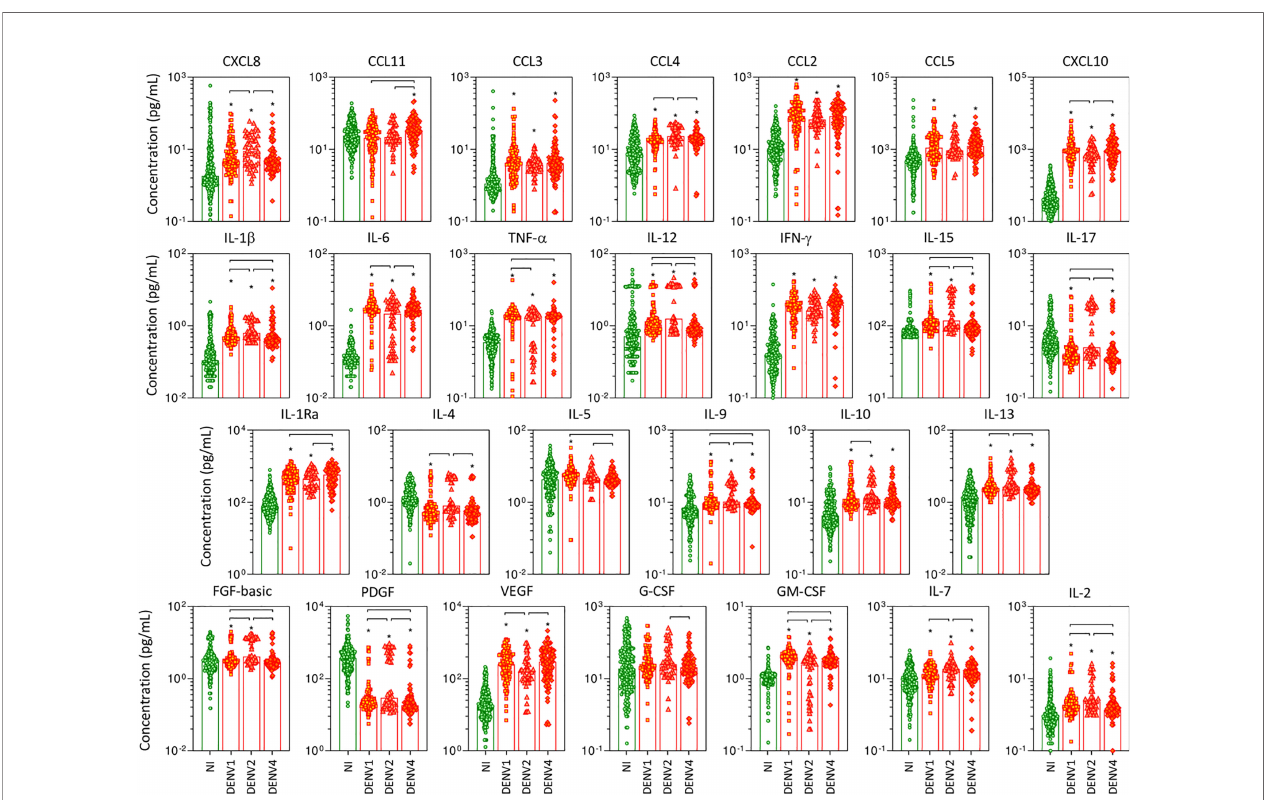
FIGURE 2 | Panoramic overview of serum soluble mediators during acute infection with distinct DENV serotypes. The levels of chemokines (CXCL8, CCL11, CCL3, CCL4, CCL2, CCL5, CXCL10), pro-in fl ammatory cytokines (IL-1 b , IL-6, TNF- a , IL-12, IFN- g , IL-15, IL-17), regulatory cytokines (IL-1Ra, IL-4, IL-5, IL-9, IL-10, IL-13), and growth factors (FGF-basic, PDGF, VEGF, G-CSF, GM-CSF, IL-7, and IL-2) were measured in serum samples from patients with acute infection with distinct DENV serotypes (n=269), referred as: “ DENV1 ” ( n=116), “ DENV2 ” ( n=52), and “ DENV4 ” ( n=101), represented by symbols/bars on the right side of each panel, as compared to the reference non-infected healthy controls – “ NI ” ( n=319), represented by green dots/bars on the left side of each panel. Quanti fi cation of serum soluble mediators was carried out by high-throughput microbeads array as described in the Material and Methods section. The results are presented as the scattering of individual values expressed in pg/mL over bar plots highlighting the median on each bar. Signi fi cant differences at p <0.05 are indicated by an asterisk (*), and connecting lines for comparisons with non-infected healthy controls and among DENV serotypes,